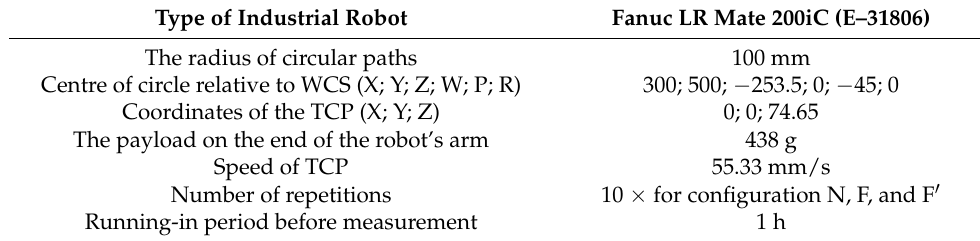
Table 4. Measurement conditions.